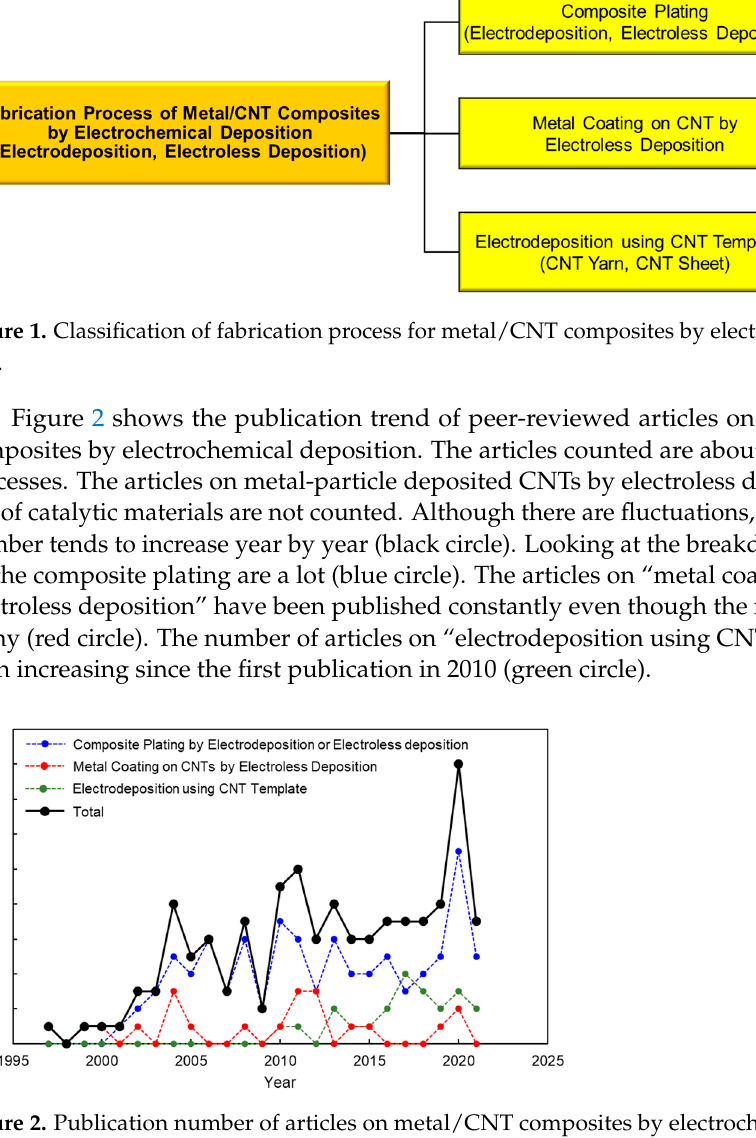
Figure 2. Publication number of articles on metal/CNT composites by electrochemical deposition during 1997–2021 (source: Web of Science).